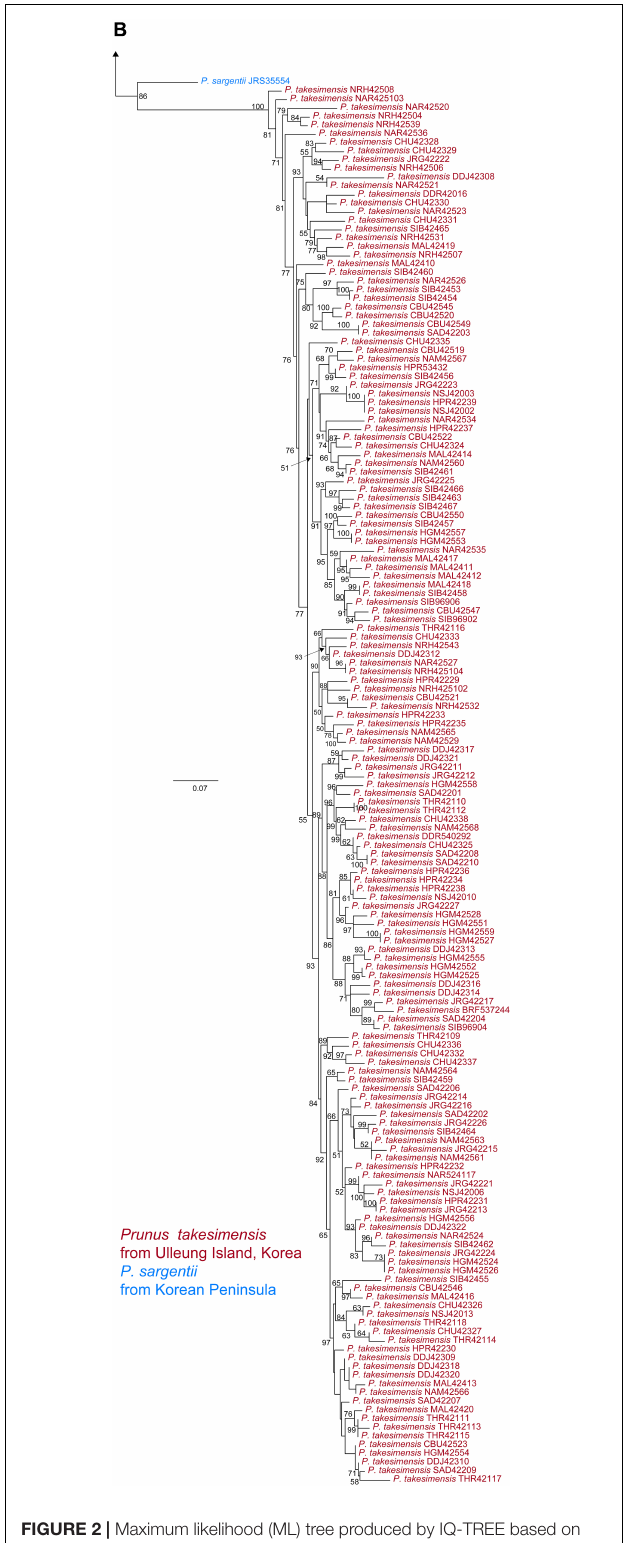
FIGURE 2 | Maximum likelihood (ML) tree produced by IQ-TREE based on SNPs detected by MIG-seq analysis, including 262 accessions of flowering cherries of the subgenus Cerasus (the genus Prunus ). Numbers above